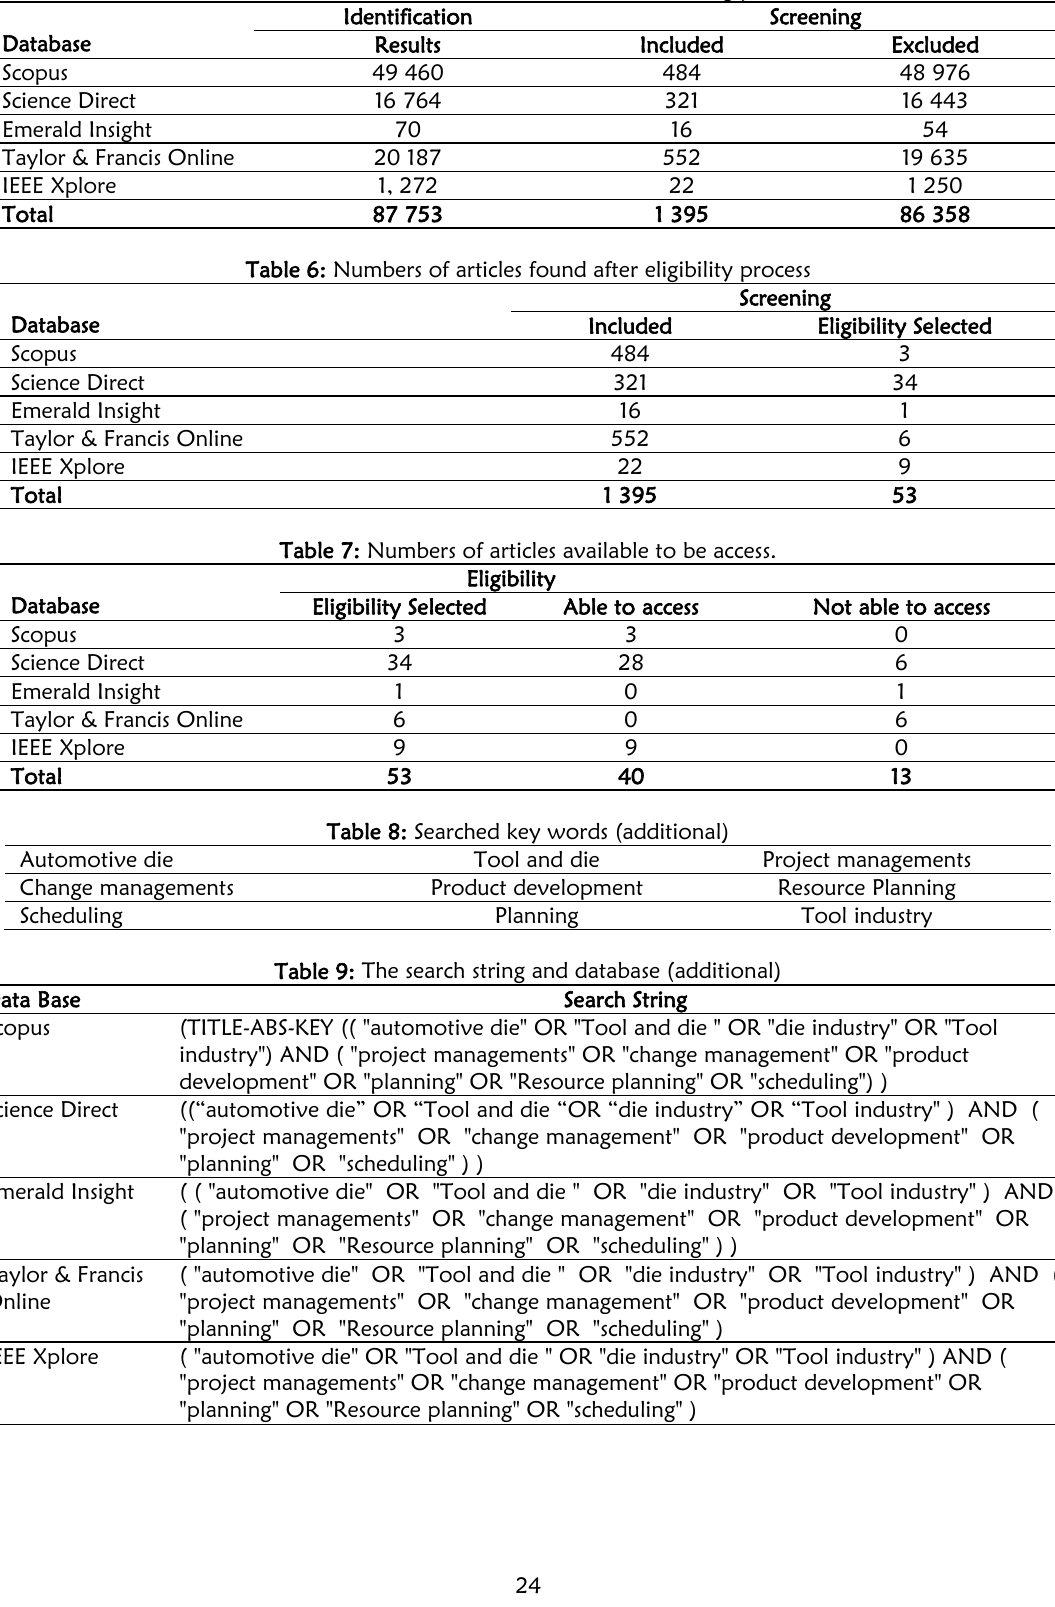
Table 5: Numbers of articles found after screening process